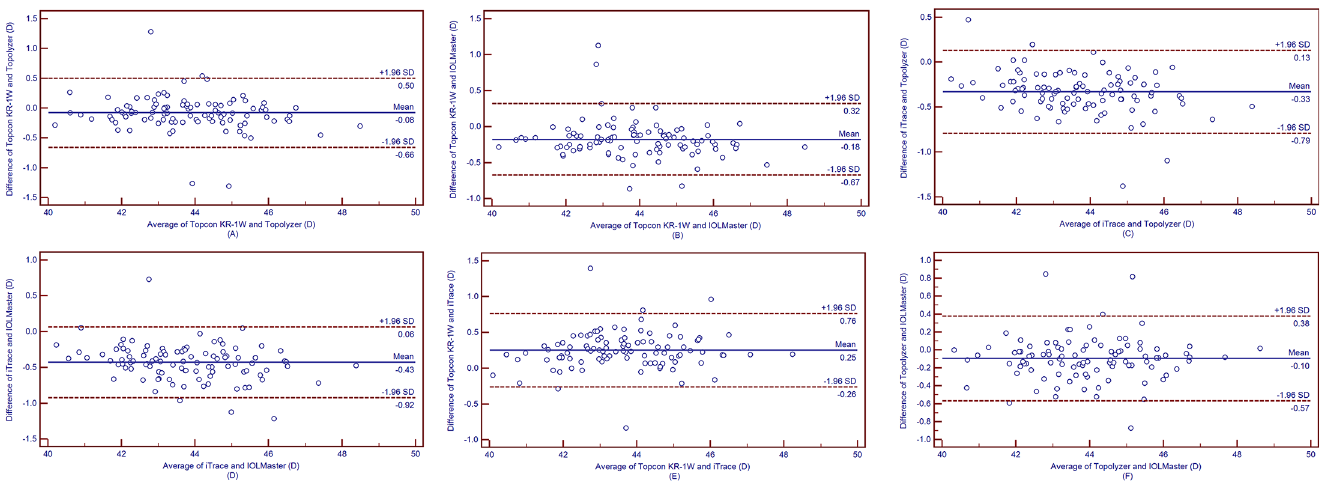
Fig 3. Band-Altman plots present the mean plotted against the differences in values of Km for a comparison between the Topcon KR-1W and Topolyzer (A), Topcon KR-1W and IOLMaster (B), iTrace and Topolyzer (C), iTrace and IOLMaster (D), Topcon KR-1W and iTrace (E), Topolyzer and IOLMaster (F). The solid line indicates the mean difference. The interval between upper and lower lines represent the 95% LoA.